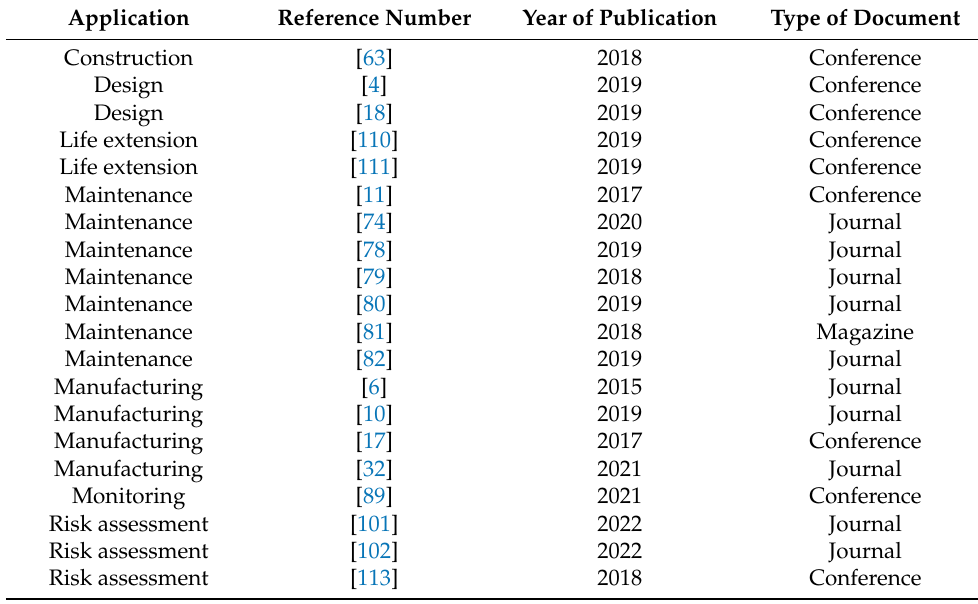
Table 1. A categorical review of the applications of digital twins on subsea